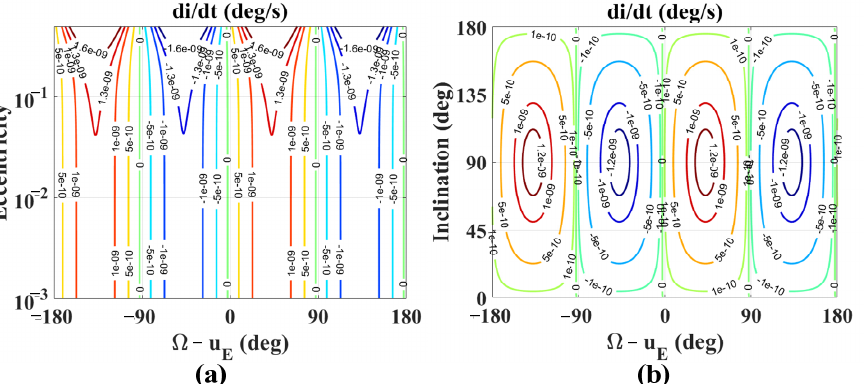
Figure 6. Rates of change of the inclination with respect to the eccentricity in subplot ( a ) and incli- nation ( b ) in subplot ( a ), for a = 1.2 R E